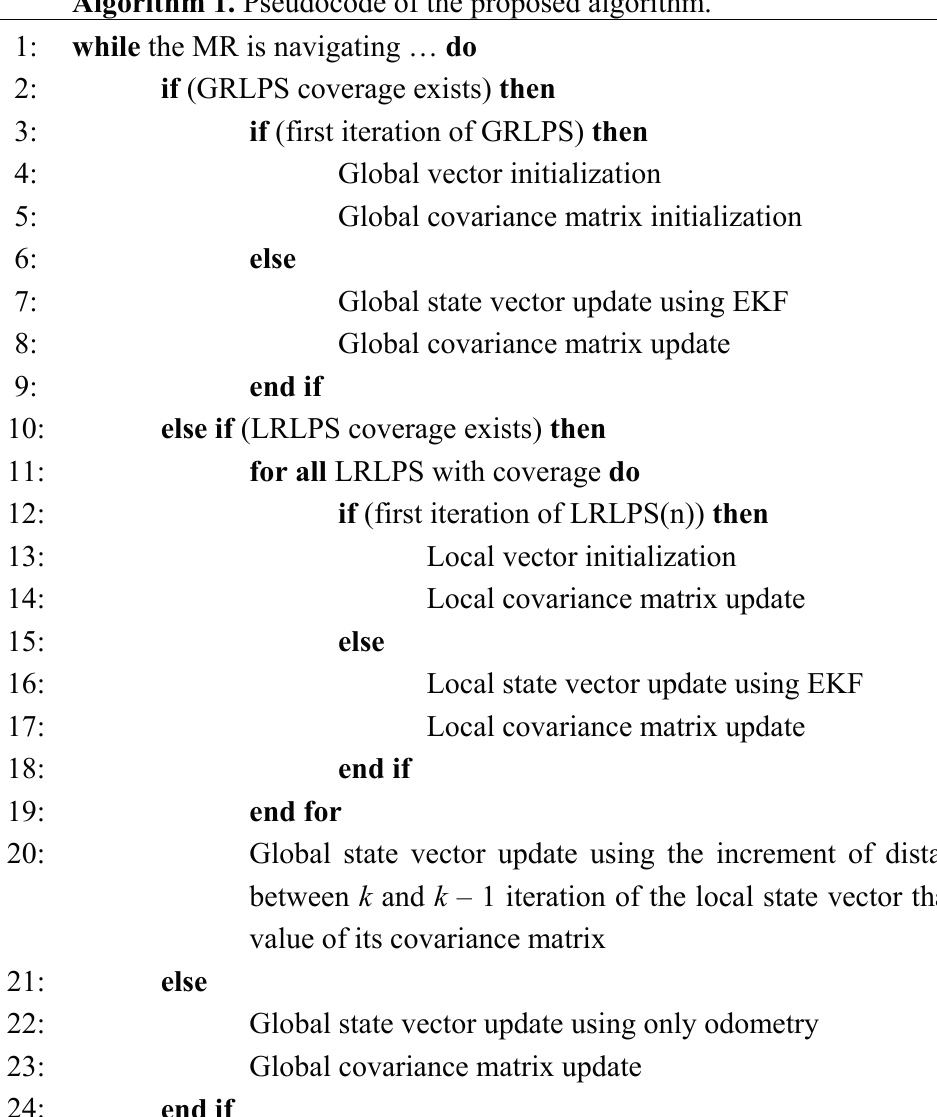
Algorithm 1. Pseudocode of the proposed